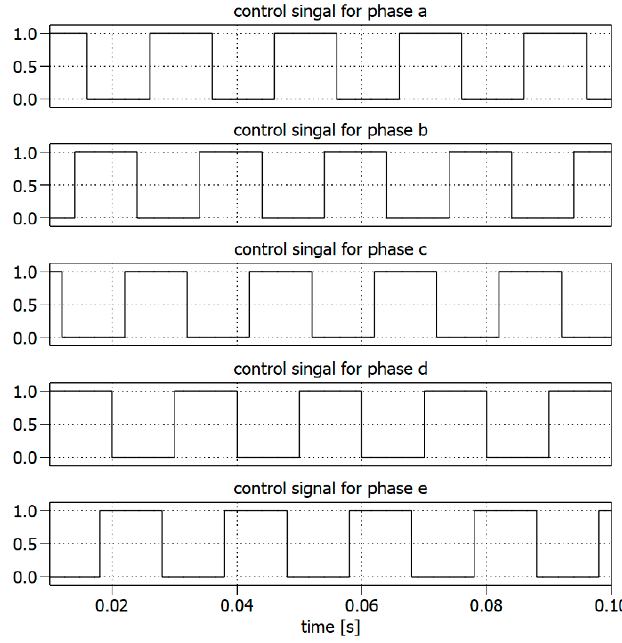
Figure 13. The control signals used in simulations.